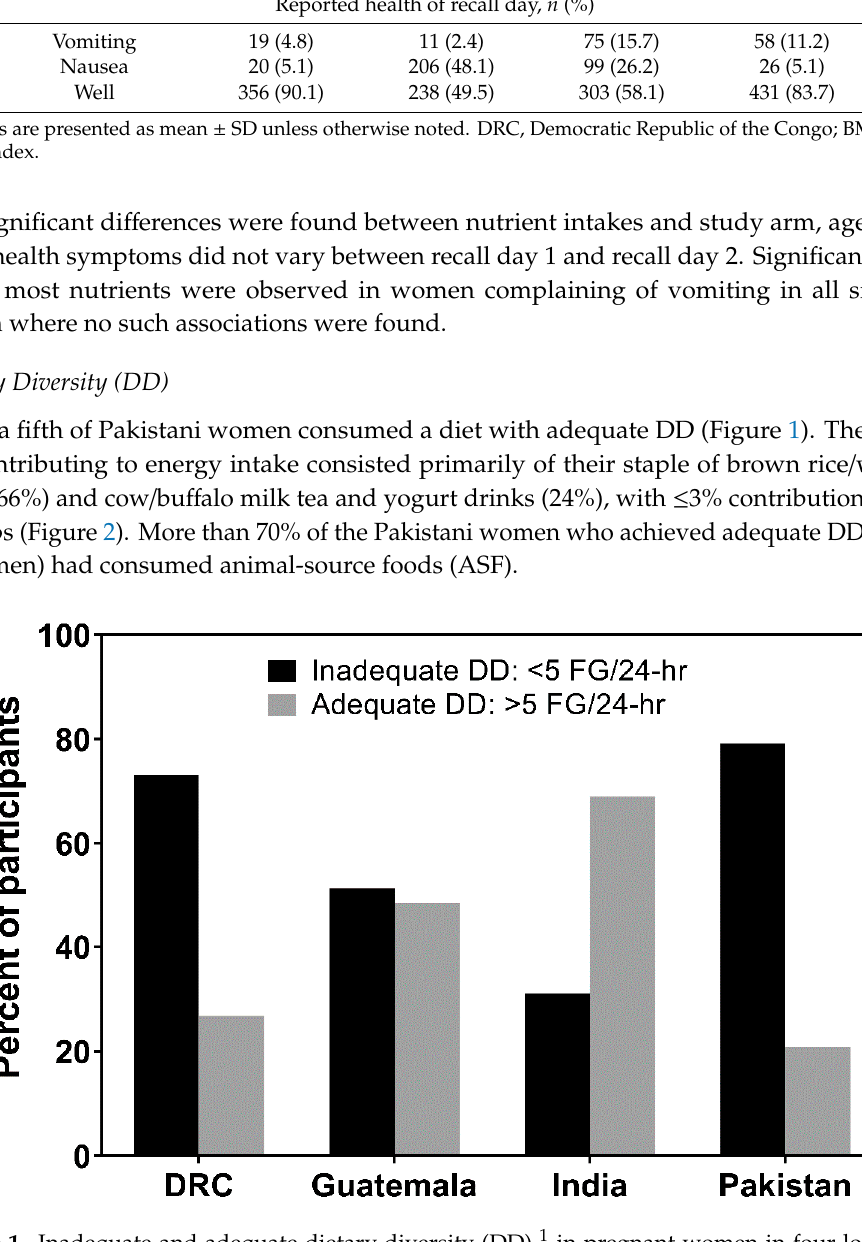
Figure 1. Inadequate and adequate dietary diversity (DD) 1 in pregnant women in four low- and middle-income countries by site. 1 Inadequate and Adequate DD, as defined by minimum dietary diversity for women of reproductive age [12], i.e., inadequate DD: consumption of < 5 major food groups (FG) in the past 24 h; adequate DD: consumption of ≥ 5 major FG in the past 24 h. DRC, Democratic Republic of the Congo.